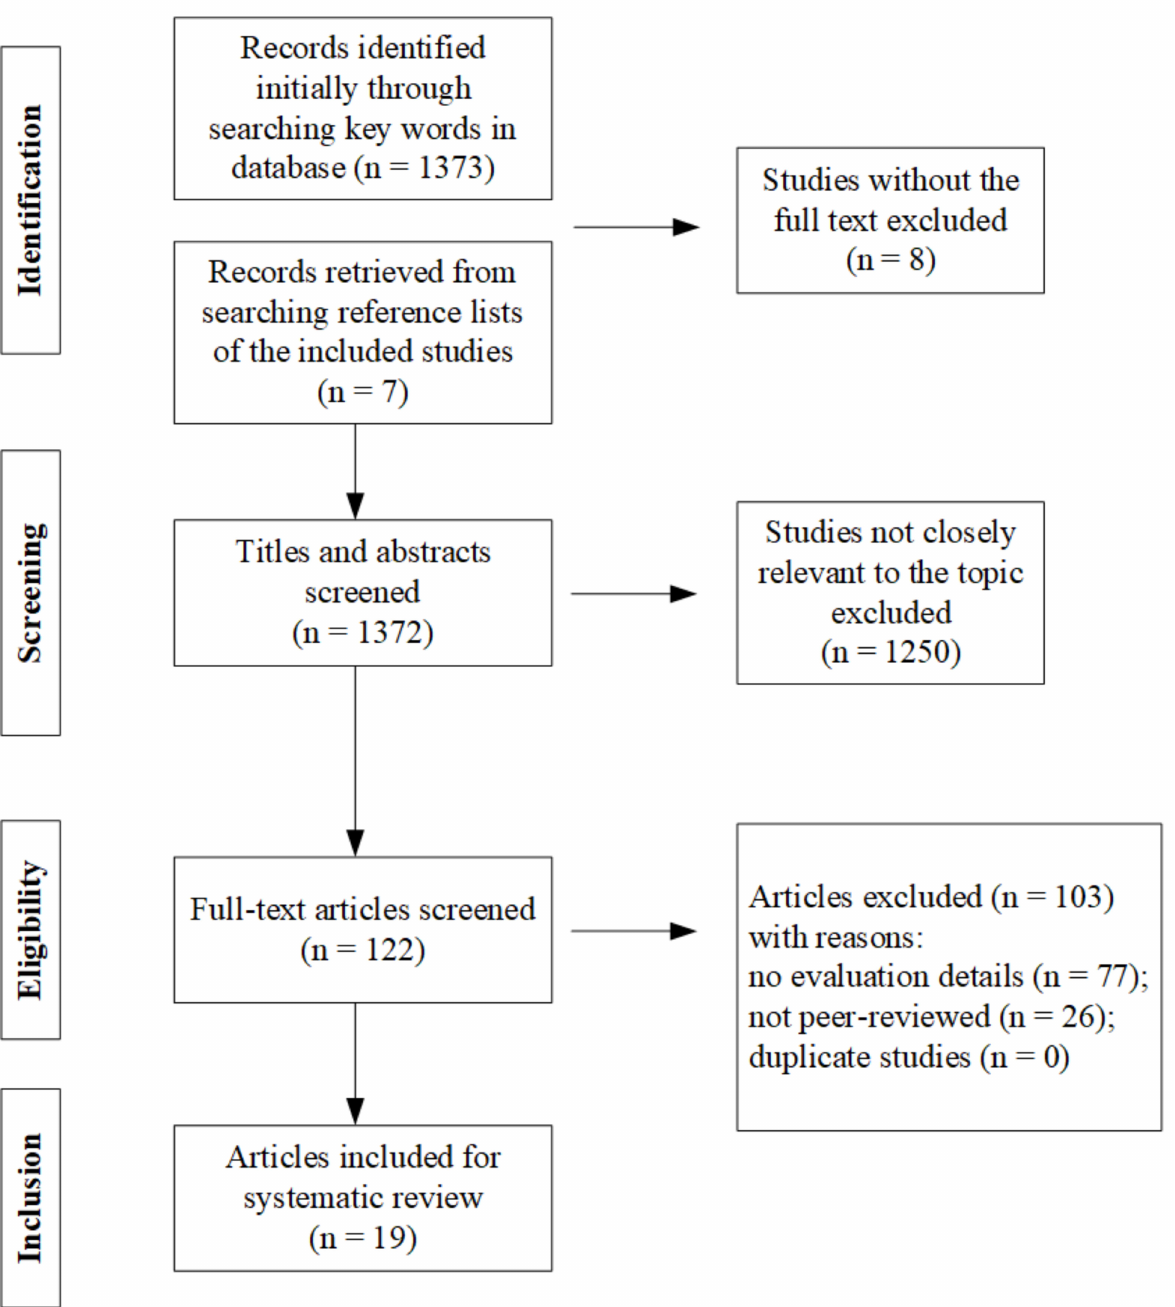
Figure 2. Flow chart of study selection